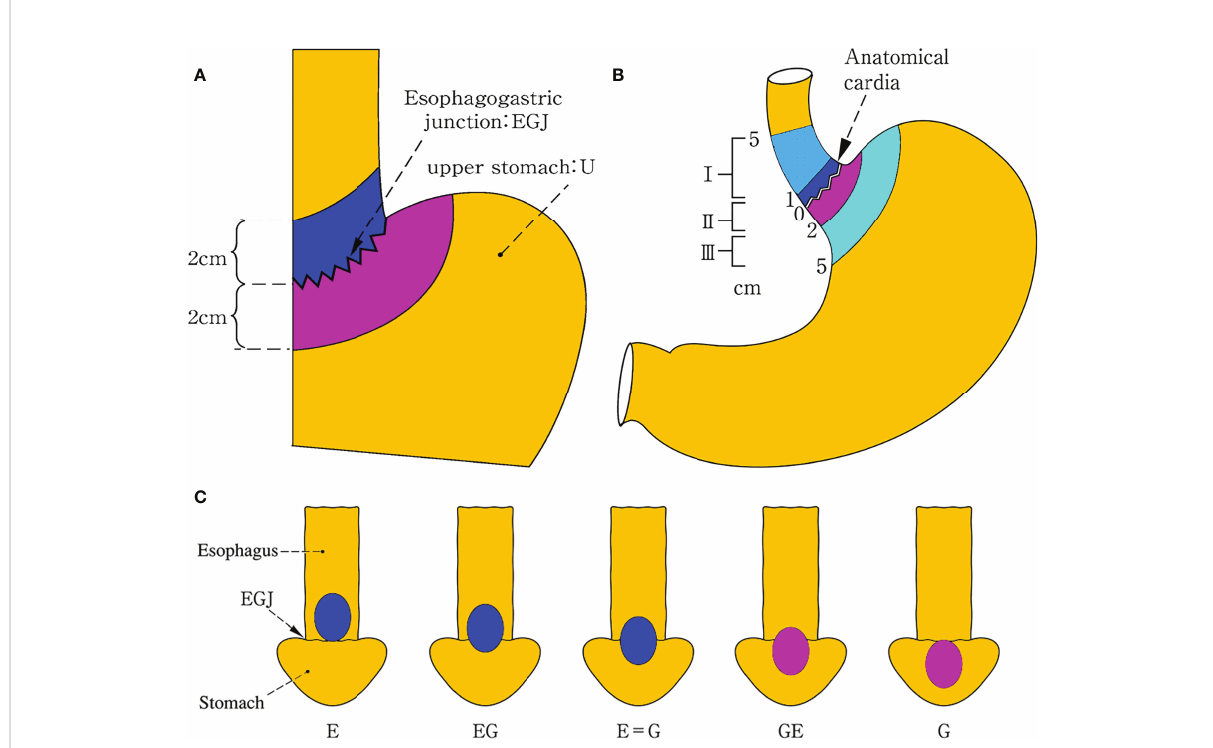
FIGURE 2 De fi nition and description of EGJ cancer. Nishi ’ s classi fi cation (A) adopted by the TNM classi fi cation of malignant tumor 8th edition, which de fi ned EGJ cancer as adenocarcinoma with an epicenter located within 2.0 cm above and below from the EGJ and corresponded to Siewert type II cancer de fi ned by Siewert ’ s classi fi cation (B) . The terms “ E, EG, E=G, GE, and G ” were used to describe the subtypes depending on the epicenter location at the oral “ E ” and anal “ G ” portions of the EGJ. E, EG, and E=G were scheduled as the esophagus-predominant tumor (E ≥ G) and G and GE as the stomach-predominant tumor (G>E) among fi ve types (C) . Both Siewert ’ s and Nishi ’ s classi fi cation clearly settled the epicenter location within 2 cm above and below the EGJ, irrespective of tumor size in the former and histological type in the latter as well as tumor extension in both. EGJ esophagogastric